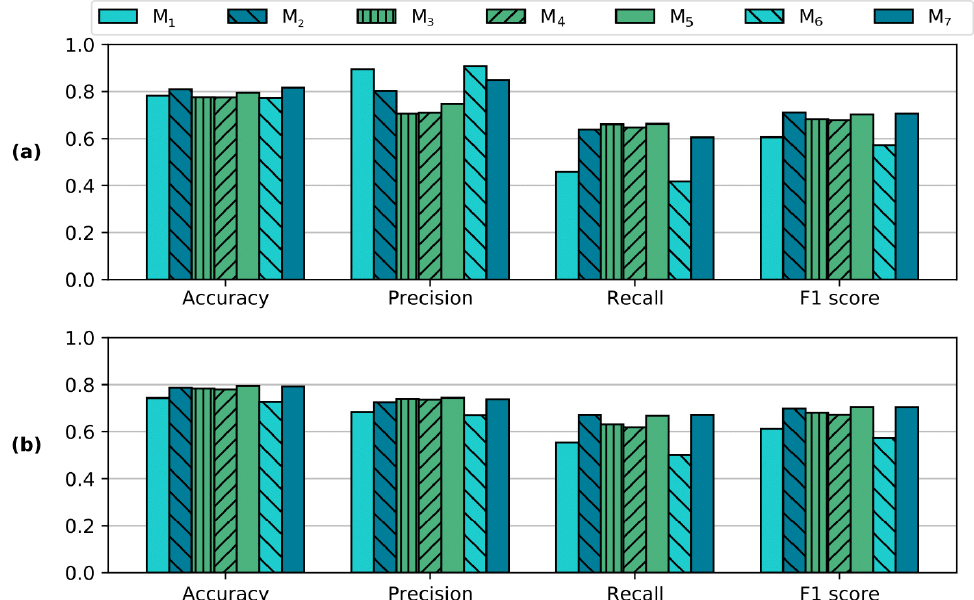
Figure 9. Performances of pigment detection. ( a ): The scores are calculated at the concentration thresholds reported in Table 3. ( b ): The scores are computed at a fixed α T = 0.15. The overall detection performance is slightly poorer when a fixed α T is used, as it is observable by the small decreases in accuracy. At the same time, the trade-off between precision and recall yields very similar F1 scores in both conditions ( a , b